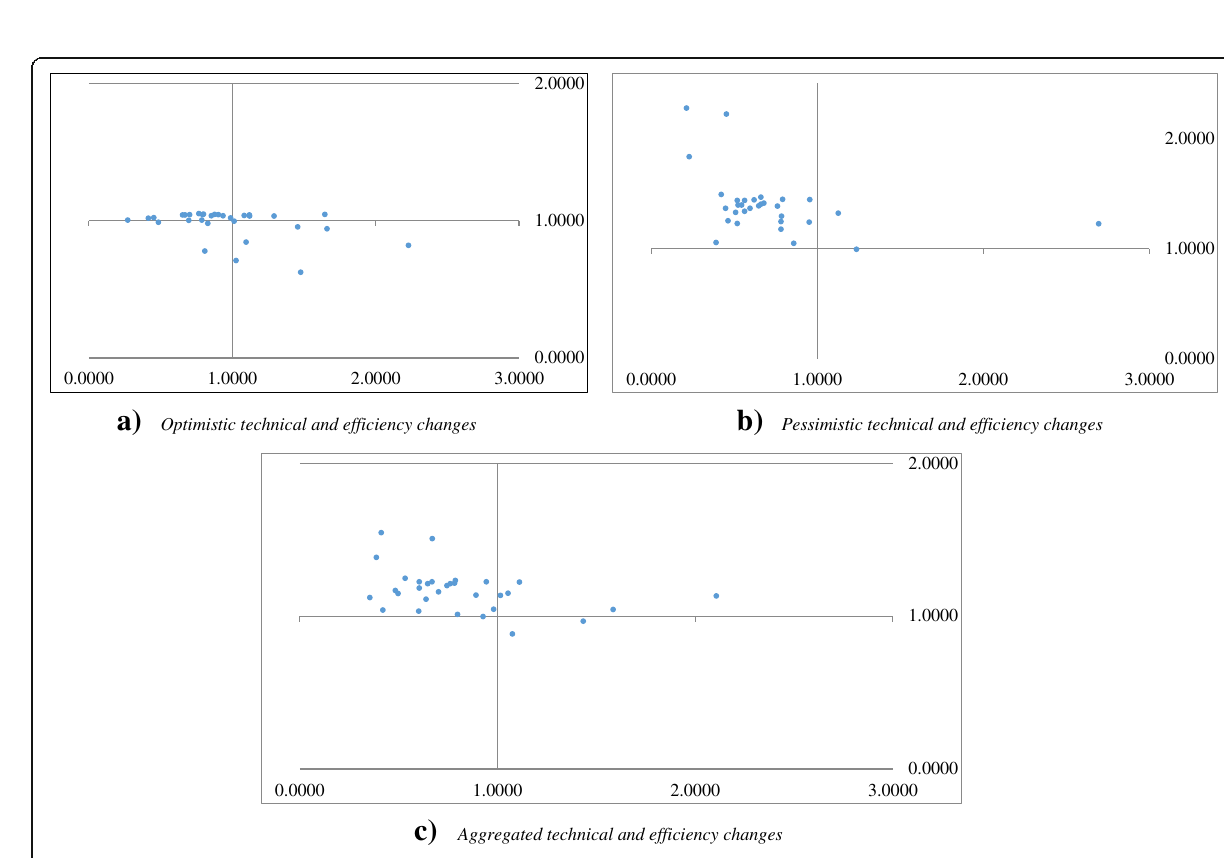
Fig. 7 The results of negative or positive productivity growth in connection with technical and efficiency changes for the 31 Iranian provinces from 2014 – 2015. Vertical axes: efficiency change. Horizontal axes: technical change